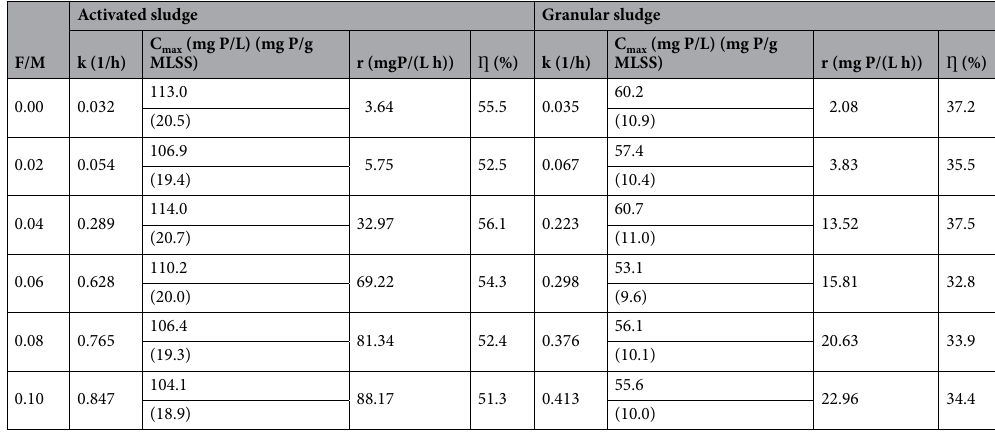
Table 2. Kinetics and effectiveness of phosphorus release from activated and granular sludge at various F/M ratios. k, constant of reaction rate; C max , maximum concentration; r, reaction rate; ƞ , effectiveness of phosphorus recovery.